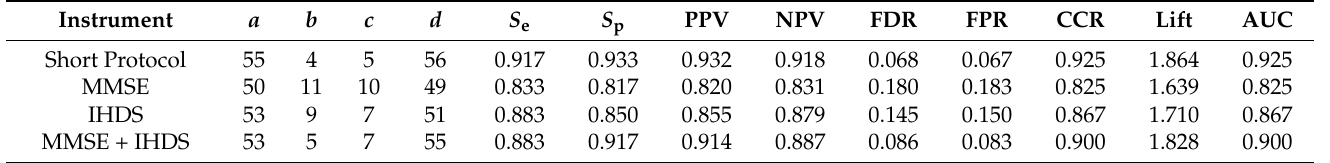
Table 4. Performance measures when different instruments are used in the ARPA-based predictive model of HAND. Overall, the proposed battery performs better than other instruments also evaluated. Here, a is the number of individuals with HAND that are correctly classified, b is the number of HAND individuals classified as controls, c corresponds to the number of control individuals classified as HAND, and d to the number of control individuals correctly classified. S e = sensitivity; S p = specificity; PPV = positive predictive value; NPV = negative predictive value; FDR = false discovery rate; FPR = false positives rate; CCR = Correct classification rate (Accuracy); AUC = area under the ROC curve (Figure 1b). See Supplementary Table S1 for expressions to calculate these performance measures form a , b , c, and d .